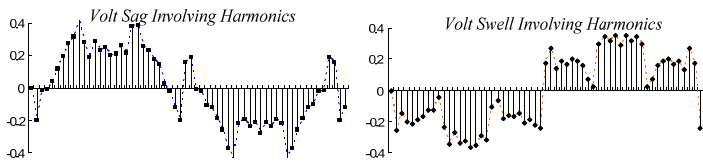
Figure 4. Pattern of harmonics of sample S5 in p.u.